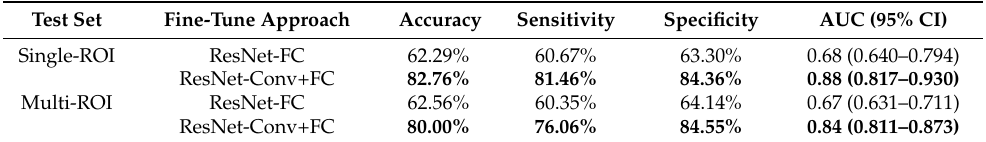
Figure 8. ( A ) ROC curve from single-ROI testing data, ( B ) ROC curve from multi-ROI test data. ResNet-FC and ResNet- Conv+FC were both observed for test data. (ROC: receiver operating characteristic, ROI: region of interest, Resnet-FC: Figure 6A, ResNet-Conv+FC: Figure 6B). Table 3. Model performance for single ROI test set and multi-ROI test set (Bold font: best